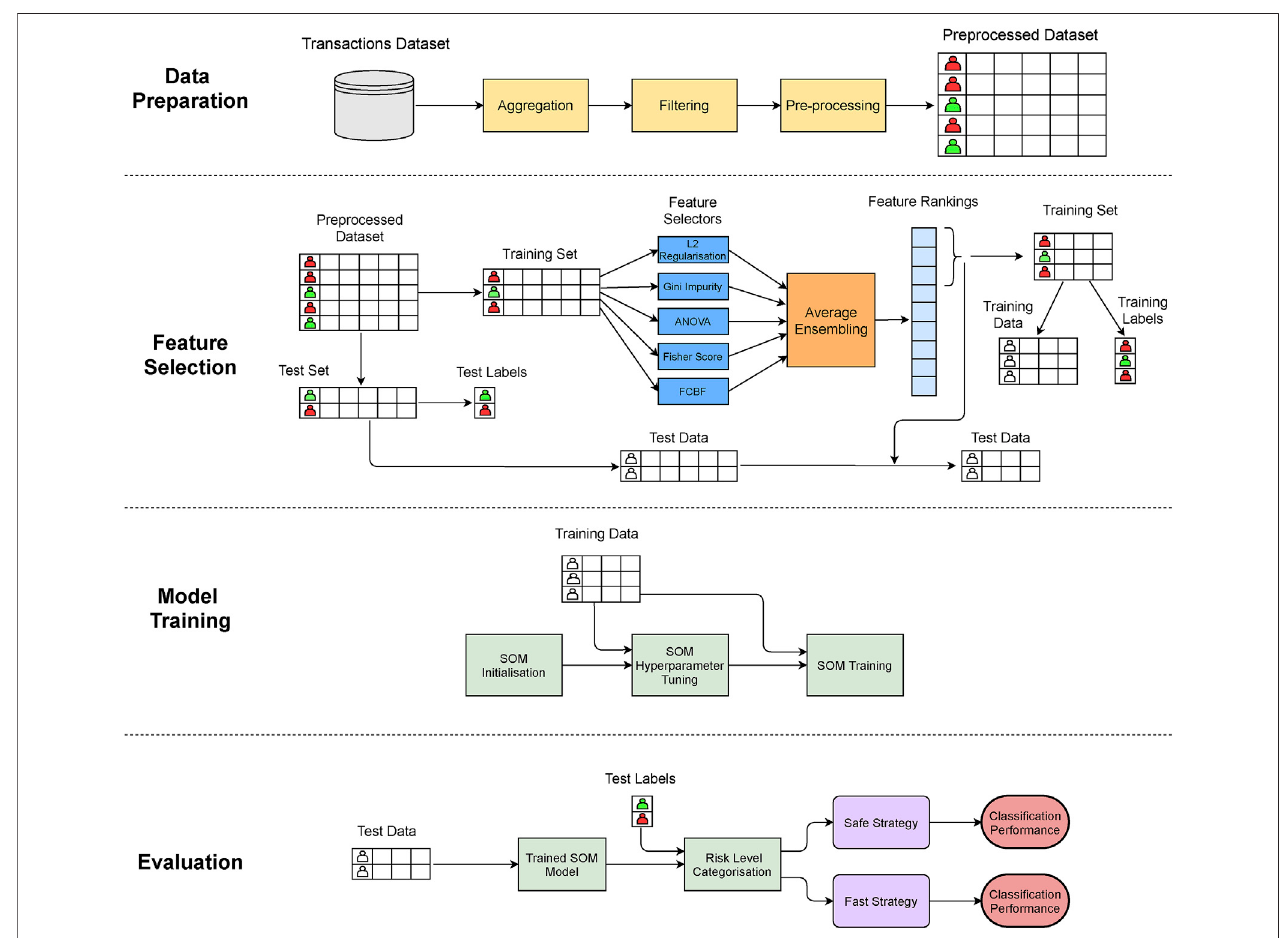
FIGURE 1 | Architecture of the SOM money laundering classi fi cation